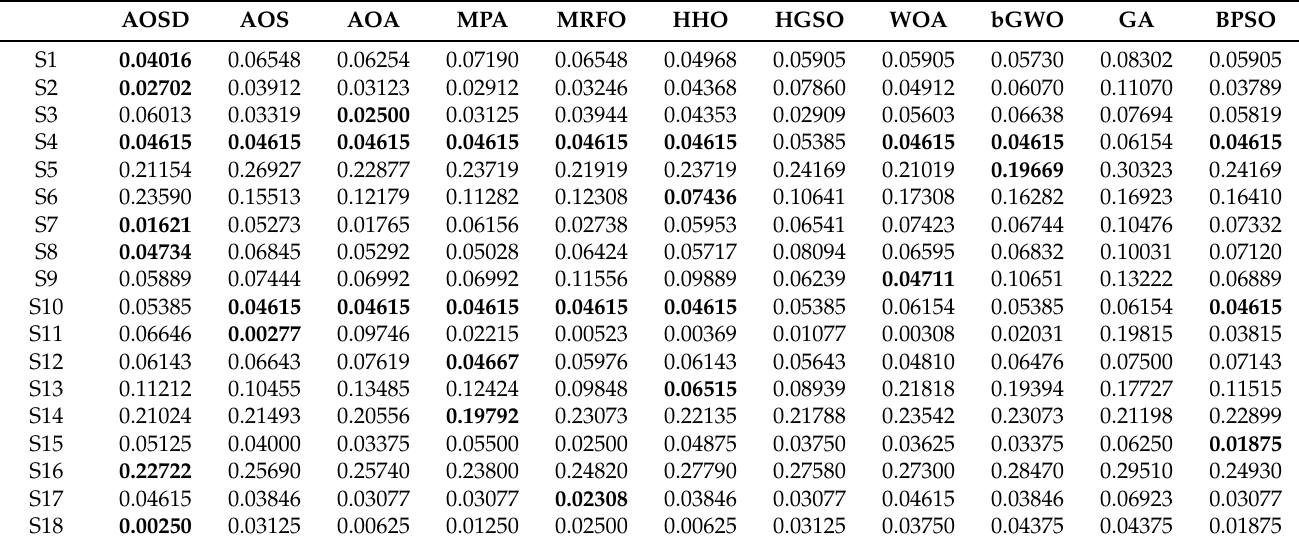
Table 5. Results of the best fitness function values for FS approaches.